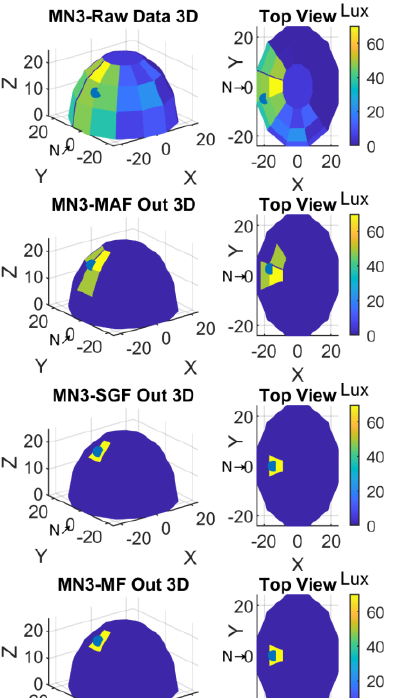
Figure 12. Spherical and top view of MN1 and MN2 experiment result. Graphic plots for the measurements from MN3 and MN4 were shown in Figure 13.